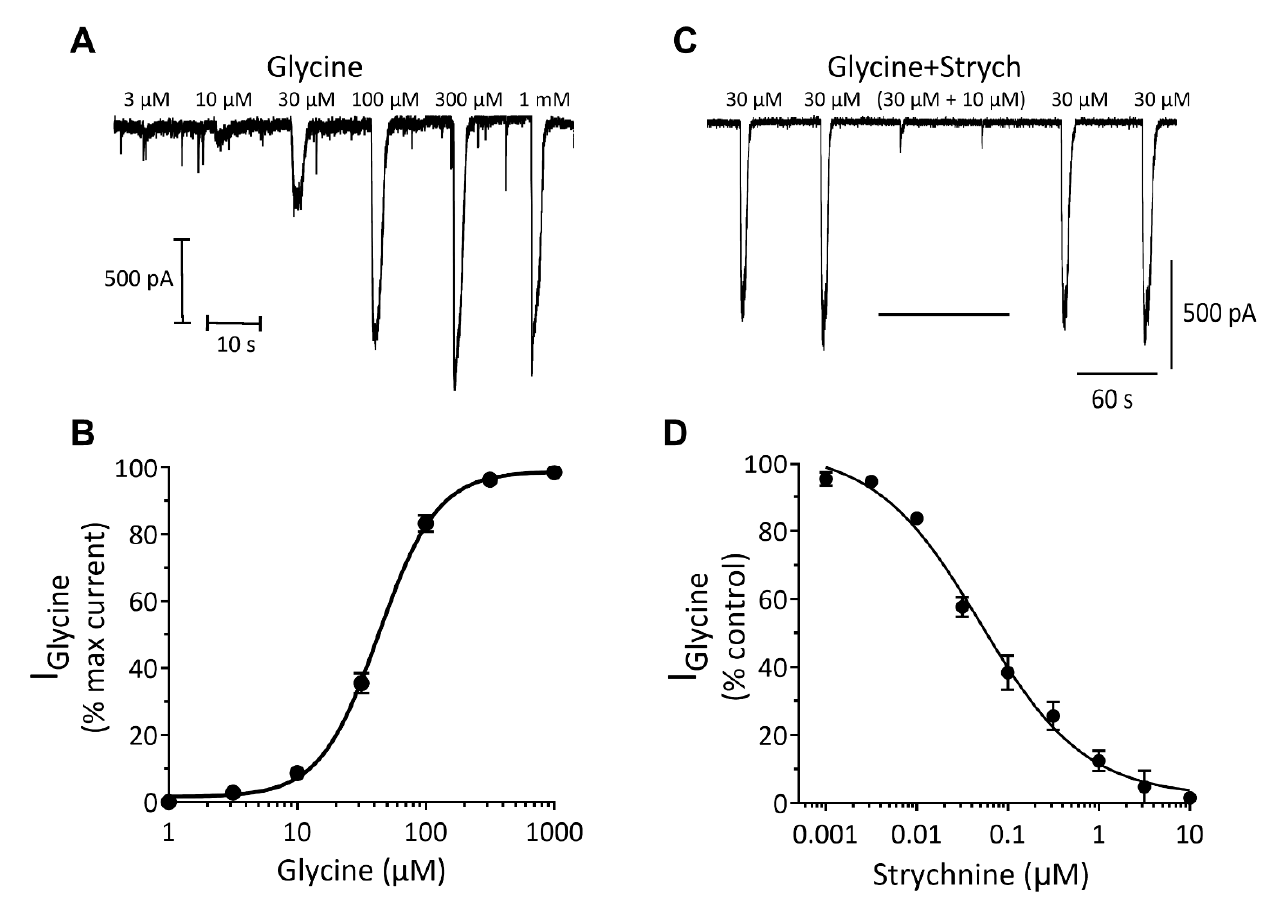
Figure 7. Glycine evokes robust concentration-dependent currents in iCell neurons. ( A ) glycine evoked inward currents recorded from a single iCell neuron held in voltage-clamp at − 60 mV. ( B ) semi-log-linear plot of the glycine dose–response relationship recorded from iCell neurons. The symbols represent the mean ± SEM of 15 cells. ( C ) strychnine (10 µ M) reversibly inhibits glycine (EC 30 ) currents in a cell held at − 60 mV. ( D ) a graph summarizing the effects of strychnine (0.001–10 µ M) on submaximal (EC 30 ) glycine evoked currents recorded from iCell neurons. The symbols represent the mean ± SEM of 4 cells.